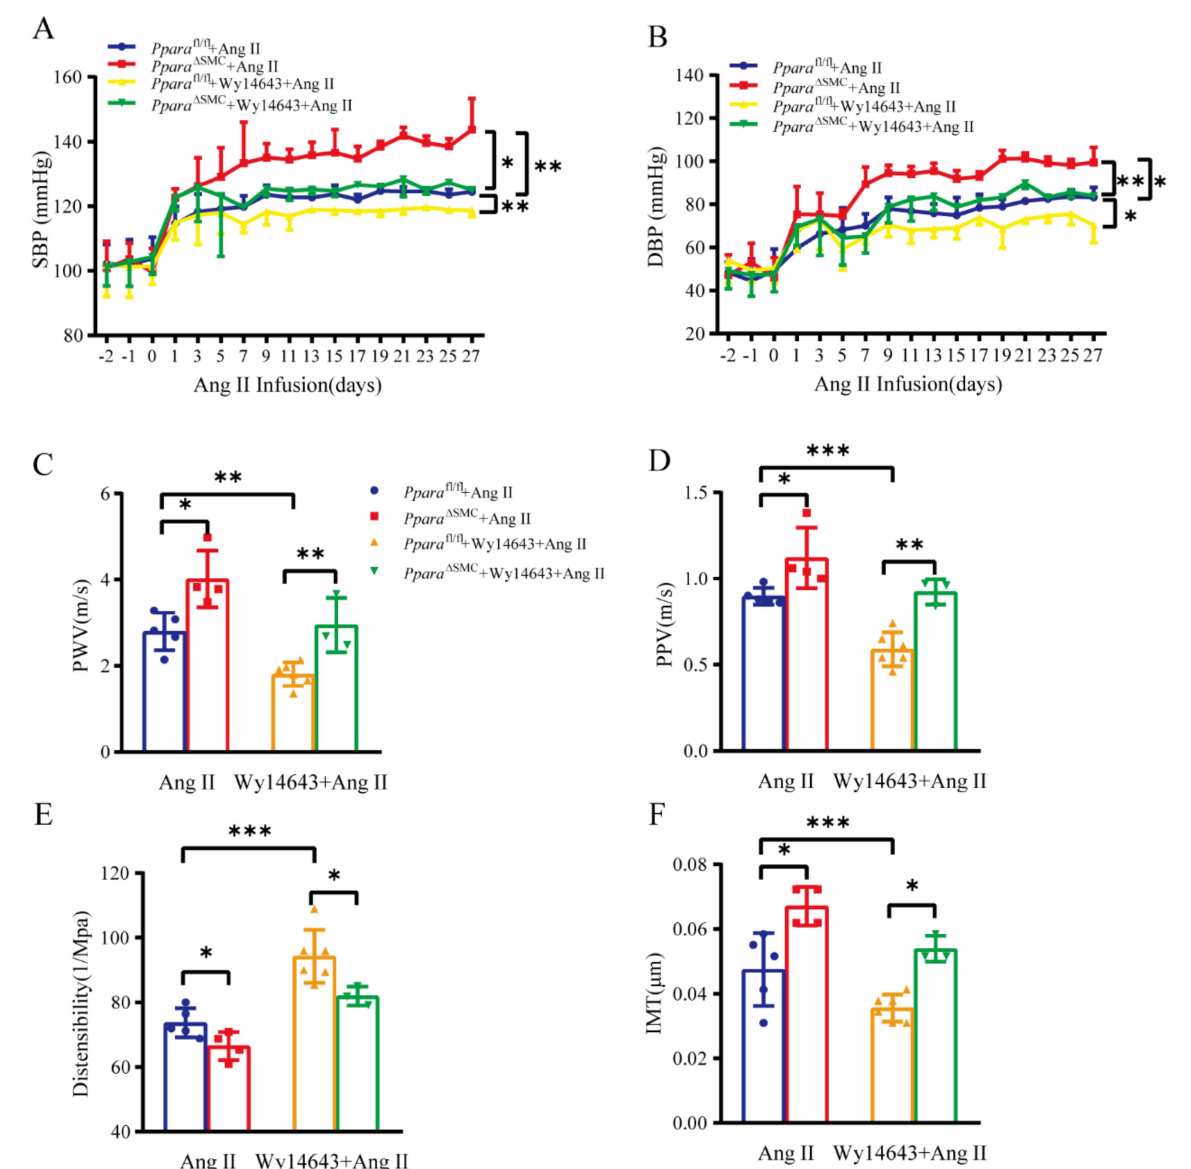
Figure 5. Activation of PPAR α by Wy14643 attenuated Ang II − induced hypertension and vascu- lar stiffness. ( A ) Systolic blood pressure (SBP) and ( B ) diastolic blood pressure (DBP) was mea- sured by noninvasive tail–cuff method before and after Wy14643 treatment in Ang II infusion mice (490 ng/kg/day). ( C ) Pulse wave velocity (PWV), ( D ) pulse pressure variation (PPV), ( E ) distensibil- ity, and ( F ) intima-media thickness (IMT) were measured by vascular ultrasound ( n = 3–6, two-way ANOVA). Data are means ± SEM. * p < 0.05, ** p < 0.01, *** p < 0.01 between